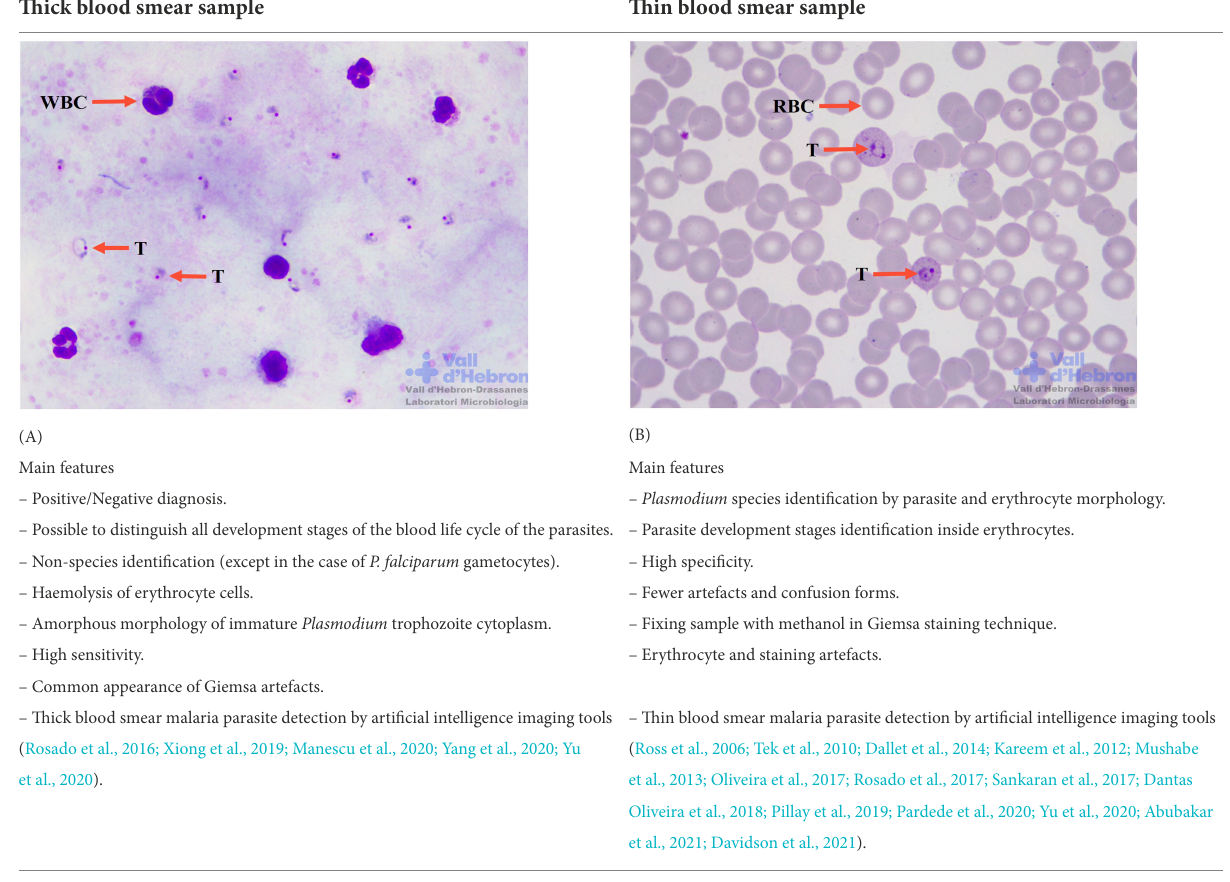
TABLE 3 Visual image differences between thick and thin blood smear samples to distinguish malaria forms by artificial intelligence techniques. (A) Thick blood smear sample 1,000x Giemsa staining. WBC nuclei and immature trophozoites (T) are distinguished with an arrow. (B) Thin